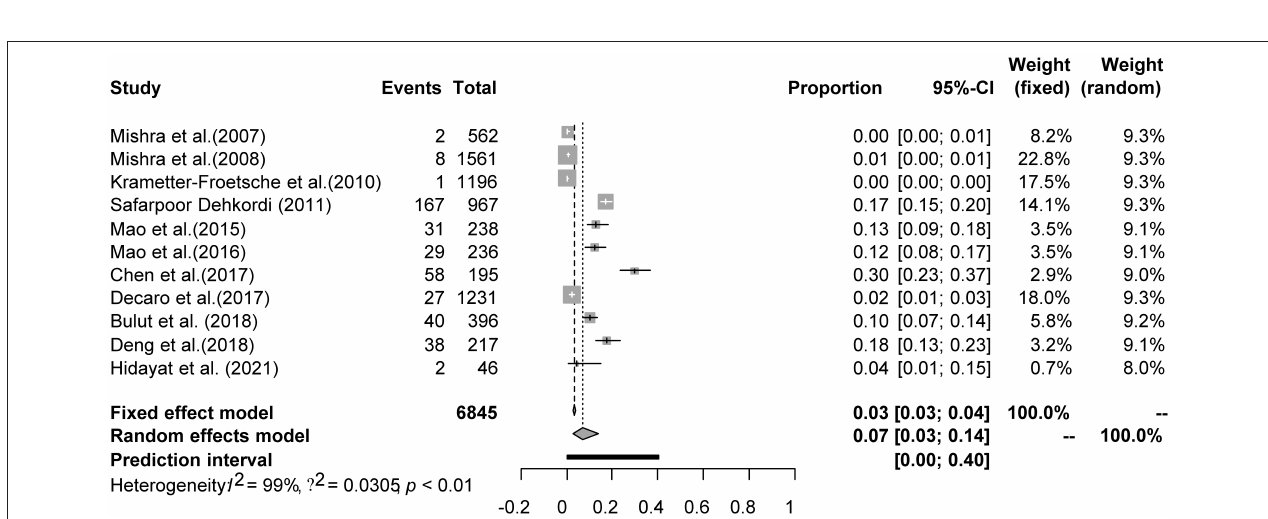
Frontiers in Veterinary Science |